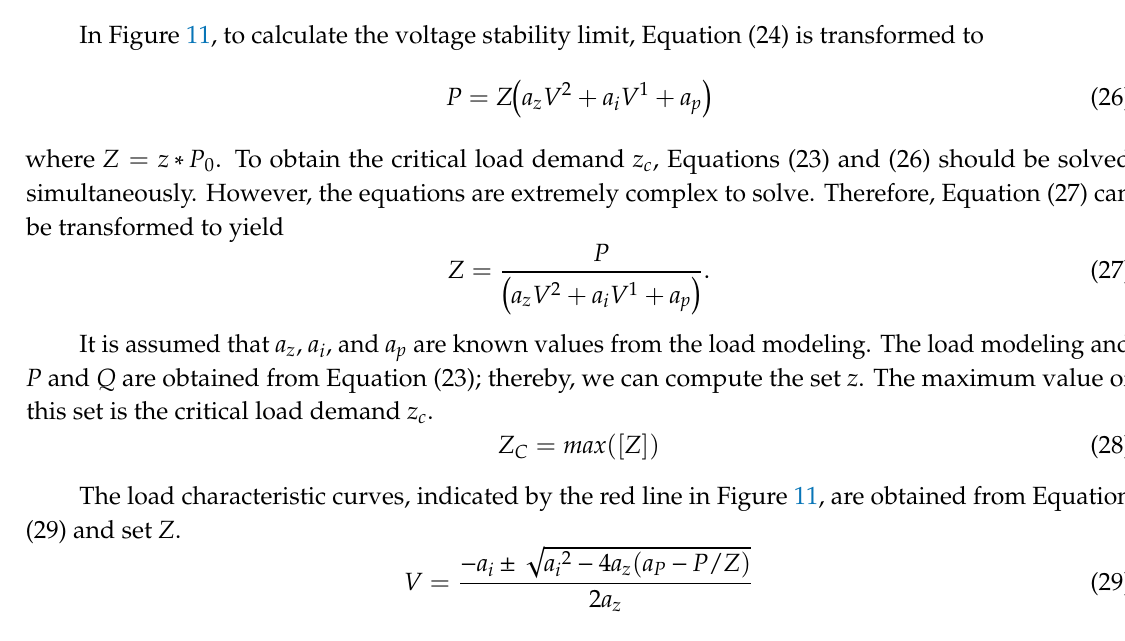
Figure 11. PV curves with the ZIP load.